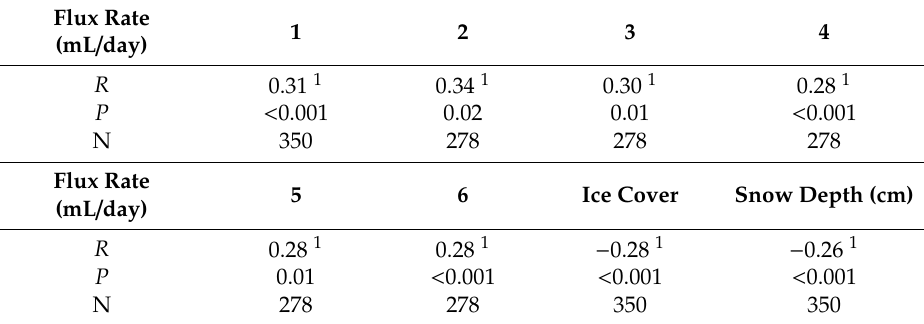
Table 4. Pearson correlation between sediment flux rate and hydrological